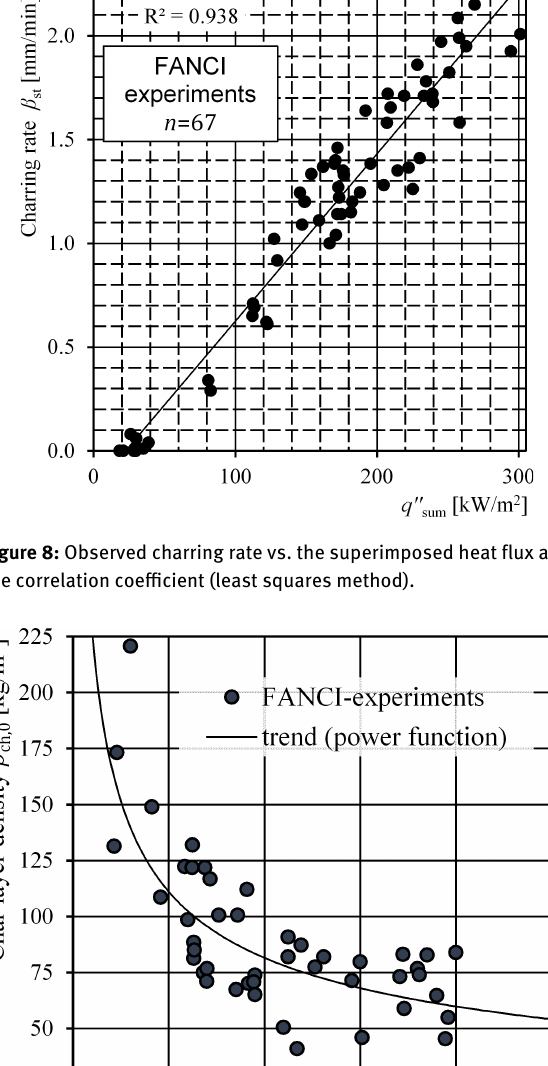
compartment experiments are included (filled squared). By trend, the additional data show that Eq. (6) delivers a slightly conservative prediction.